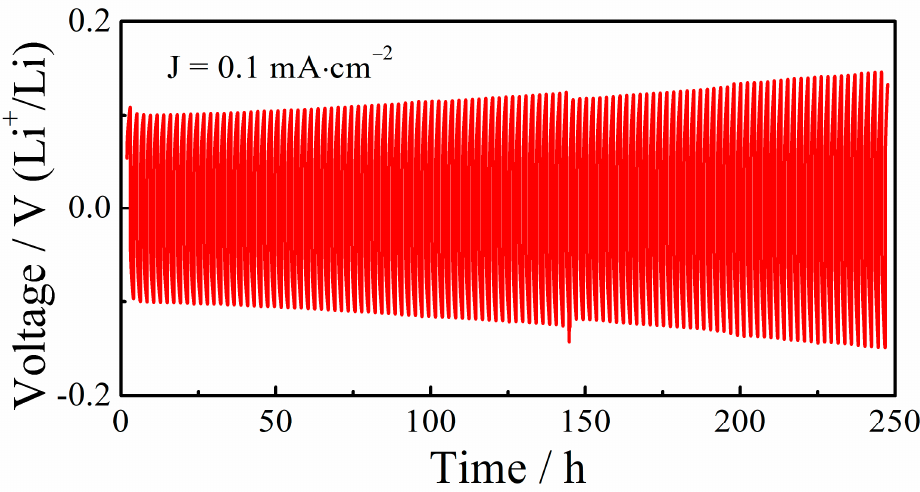
Figure 7. Chronopotentiometry results obtained in the Li plating/stripping test (0.1 mA ∙ cm − 2 , 0.1 mAh ∙ cm − 2 ). 0.1 mAh cm − 2